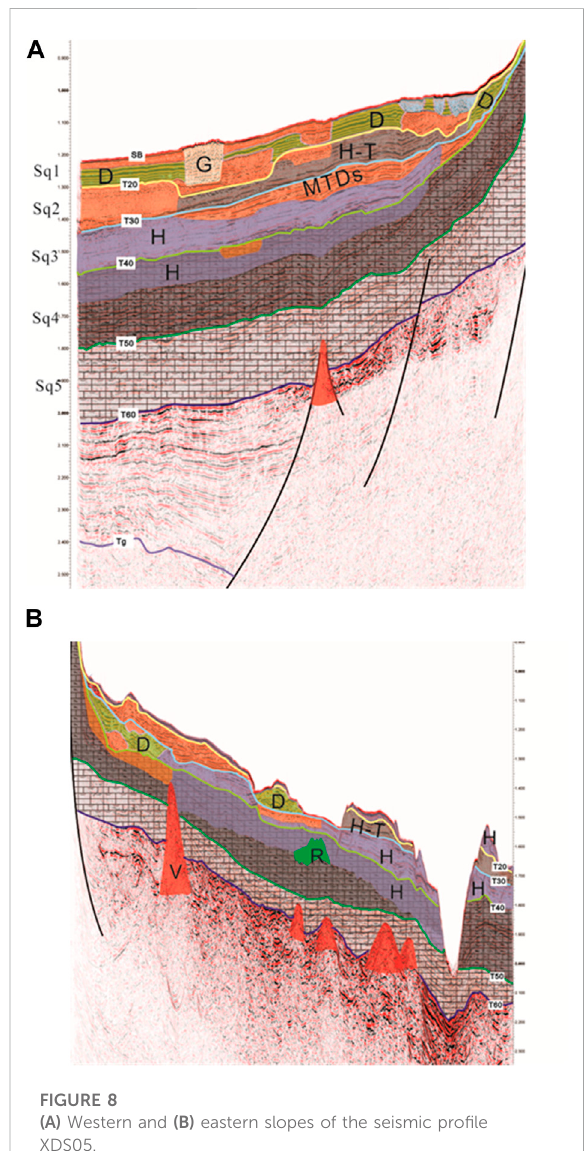
FIGURE 8 (A) Western and (B) eastern slopes of the seismic pro fi le